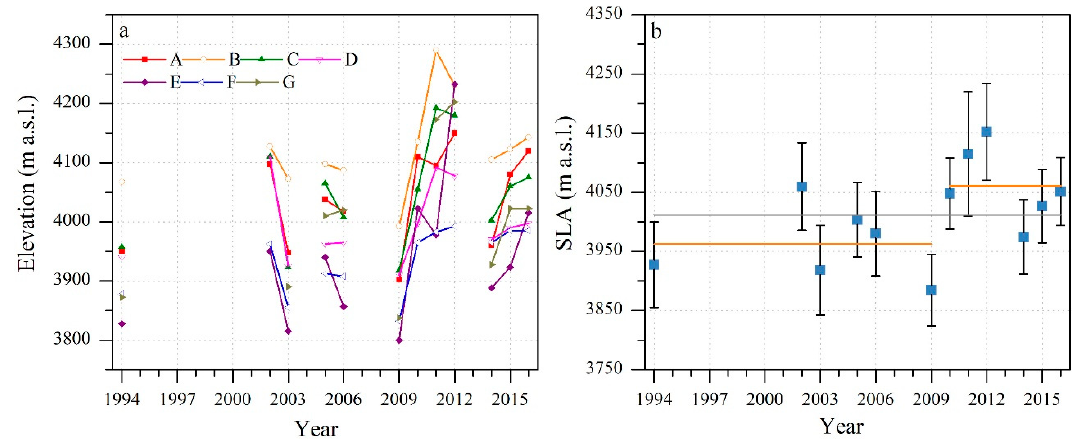
Figure 8. The annual snow line altitude (SLA) for individual glaciers (a), and the mean SLA for seven glaciers (b) during the period of 1994 to 2016. The gray solid lines show the average SLA over 1994 ‒ 2016, and the orange solid lines show the average SLA before and after 2010.